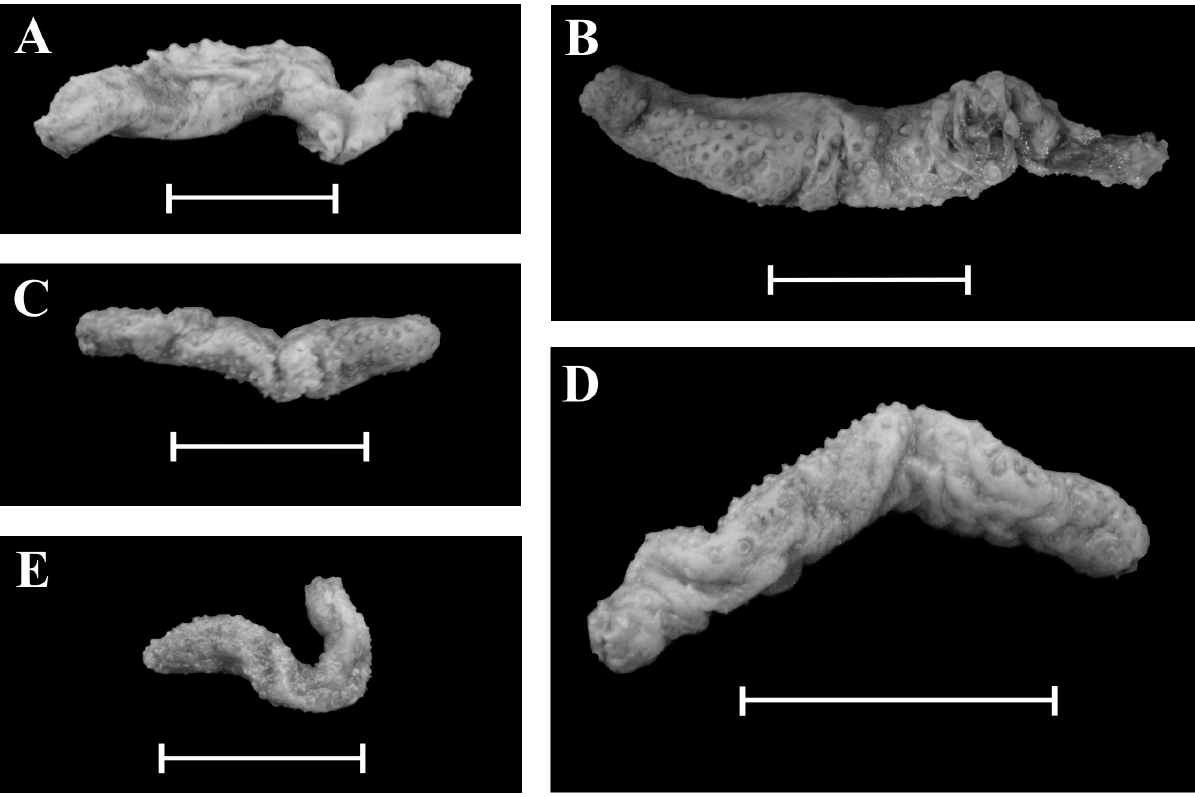
Fig . 1. – Synallactes virgulasolida n. sp. A, dorsal view of the holotype; B, ventral view of the holotype; C, general view of paratype 1; D, lateral view of paratype 1; E, general view of paratype